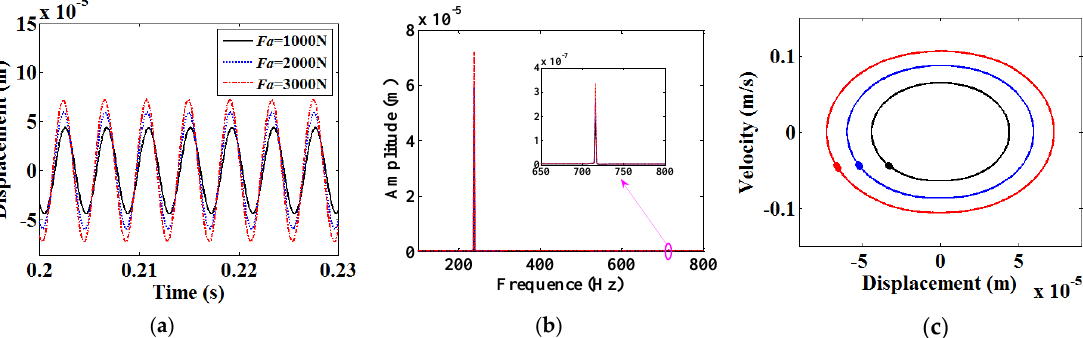
Figure 12. Vibration responses at ω = 1500 rad/s: ( a ) Time history; ( b ) Spectrum; ( c ) Phase diagram and Poincaré section.